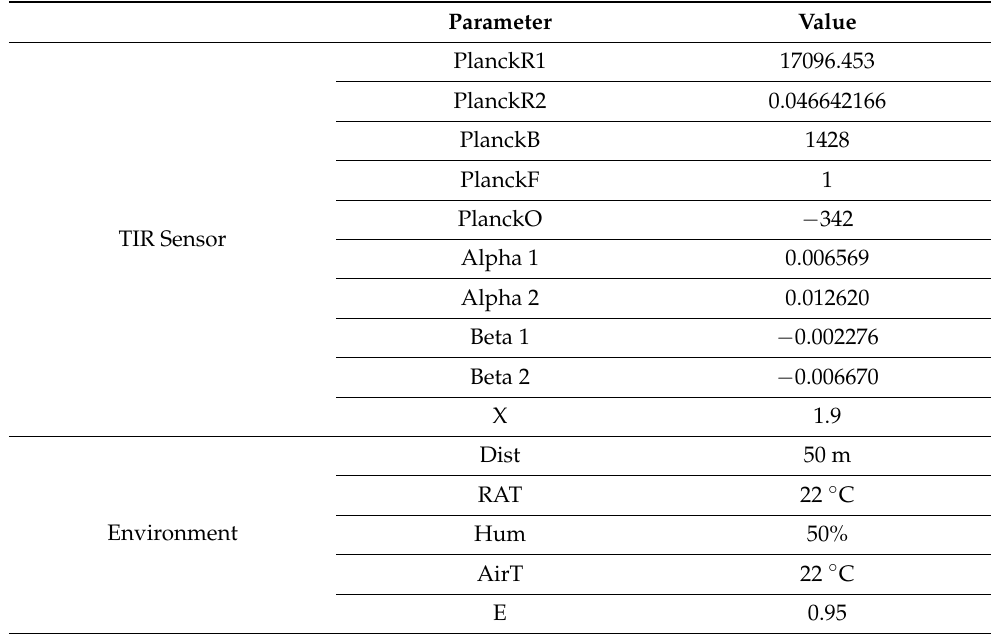
Table 3. The parameters for the TIR sensor and environment included in Equations (7)–(12). Parameter Value